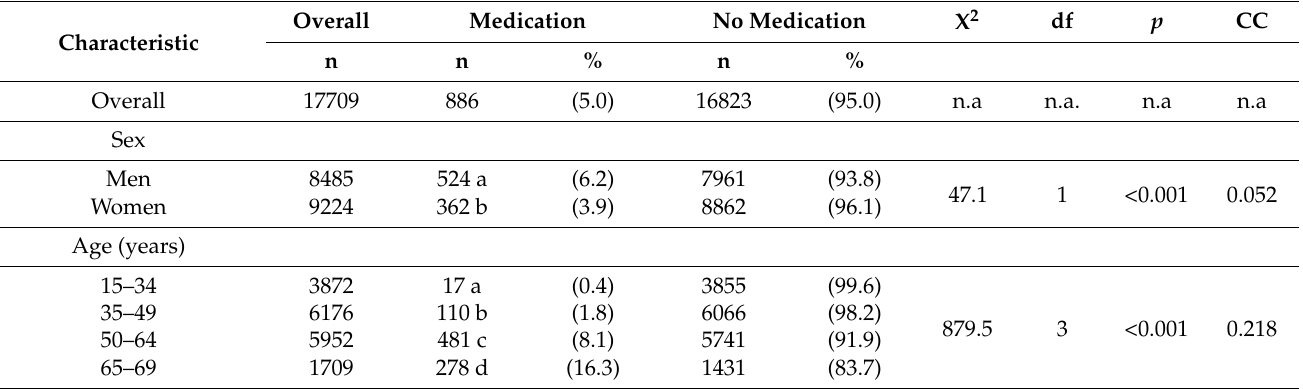
Table 2. Population Characteristics by Diabetes Medication Use in